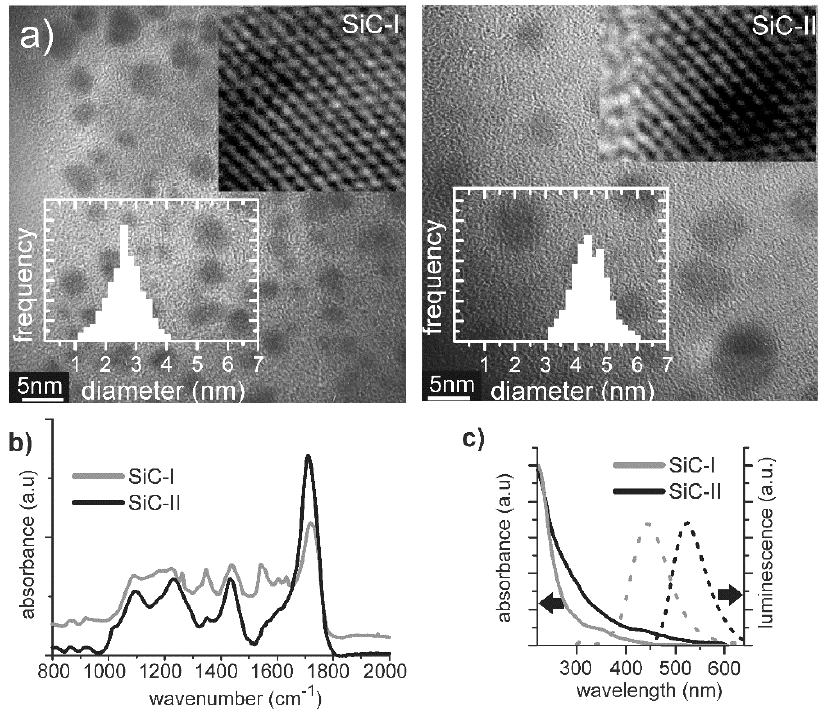
Figure 1. ( a ) High-resolution transmission electron microscopy (HR-TEM) images of as-prepared ultrasmall, 1–3 nm SiC (SiC-I), and larger, 4–6 nm (SiC-II) SiC, NPs with the corresponding size distribution; ( b ) FTIR spectra of SiC-I and SiC-II representing the surface termination of the particles; ( c ) UV-VIS absorption and photoluminescence spectra of SiC-I and SiC-II; from the UV-VIS and the photoluminescence excitation (PLE) spectra (not shown), one can calculate the optical bandgap of the NPs.